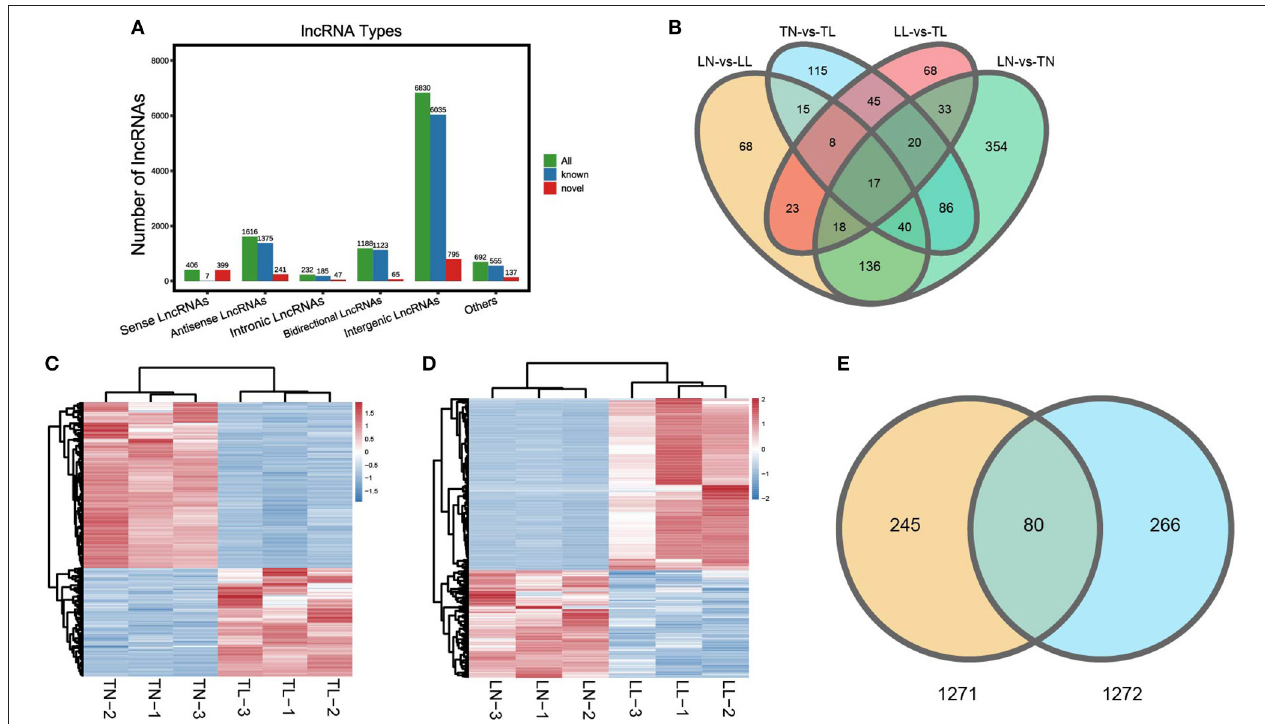
FIGURE 1 | Categories and features of the lncRNAs in ATII cells of Tibetan pigs and Landrace pigs. (A) Categories and types of lncRNAs originating from different genomic sites. (B) Venn diagram of lncRNAs interactions based on the overlapping DElncRNAs. (C) Heatmap of lncRNAs in ATII cells between the TN and TL groups. (D) Heatmap of lncRNAs in ATII cells between the LN and LL groups. (E) Common DElncRNAs shared between the normoxic (TN and LN) and hypoxic (TL and LL)